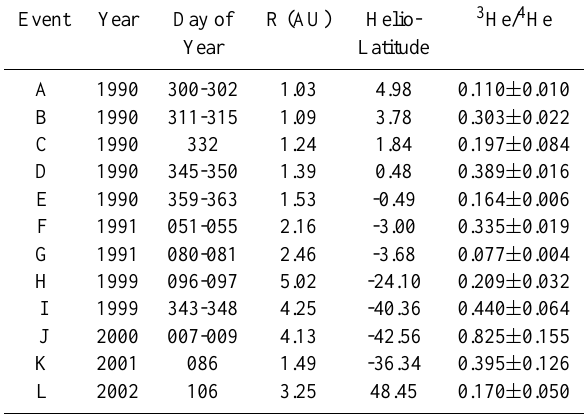
Table 1. The 12 periods of enhanced 3 He fluxes identified in this study with an event integrated ratio of 3 He/ 4 He exceeding 0.05. The table provides details of the date and location (heliocentric distance (R) and helio-latitude) of each event, and the derived 3 He/ 4 He ratio Event